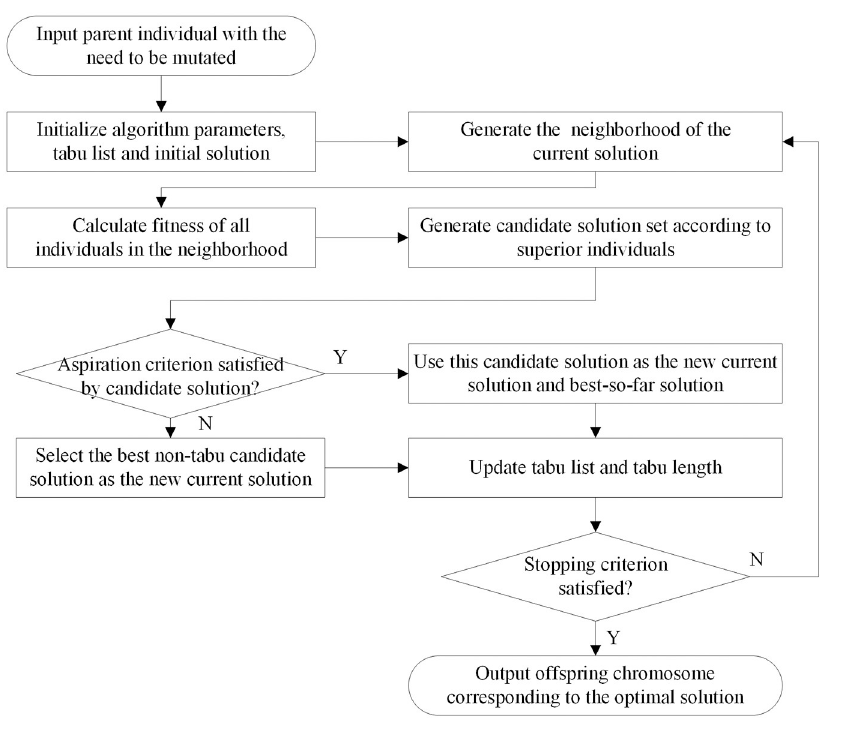
Fig 13. Flow chart of the tabu search mutation